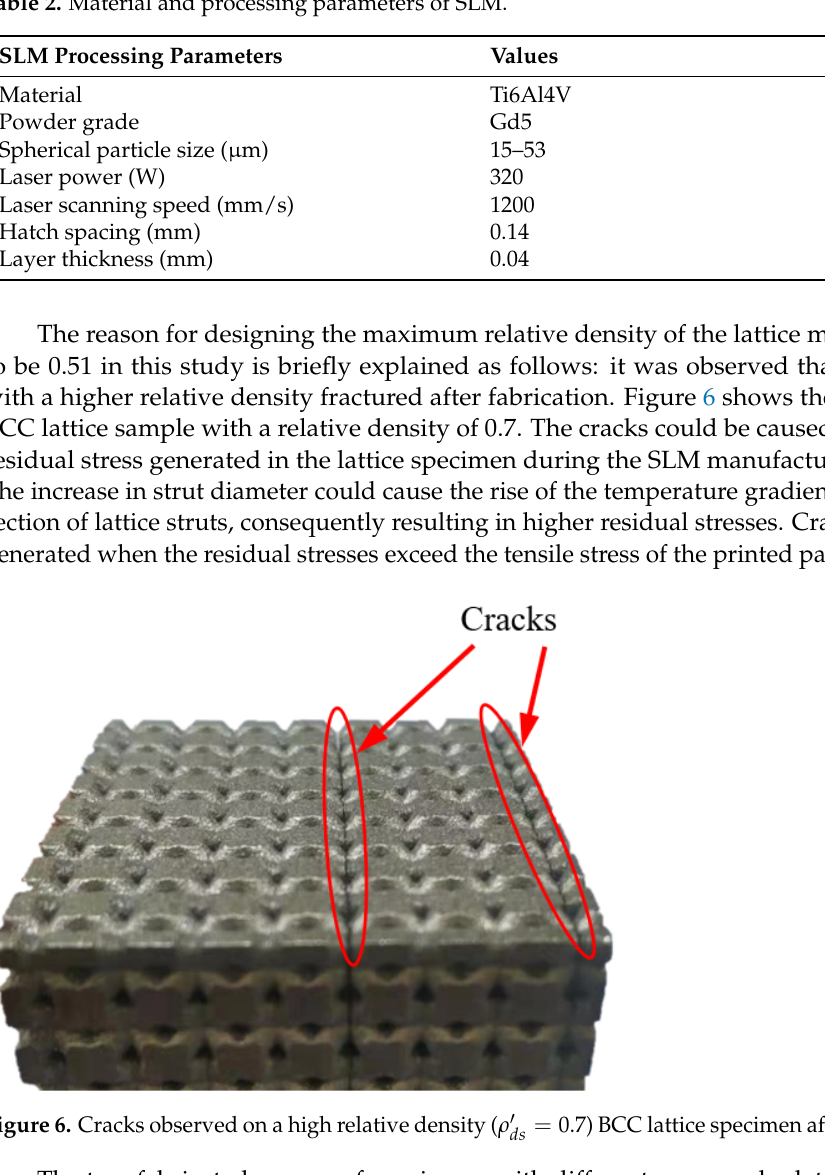
Figure 6. Cracks observed on a high relative density ( 𝜌